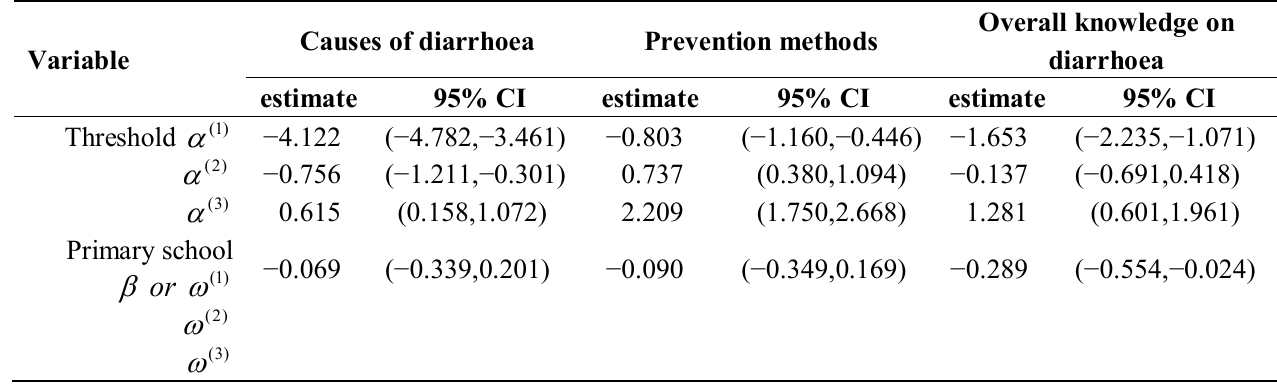
Table 4. Partial proportional odds models to identify determinants of responsible mothers’ knowledge on overall knowledge, causes and prevention of